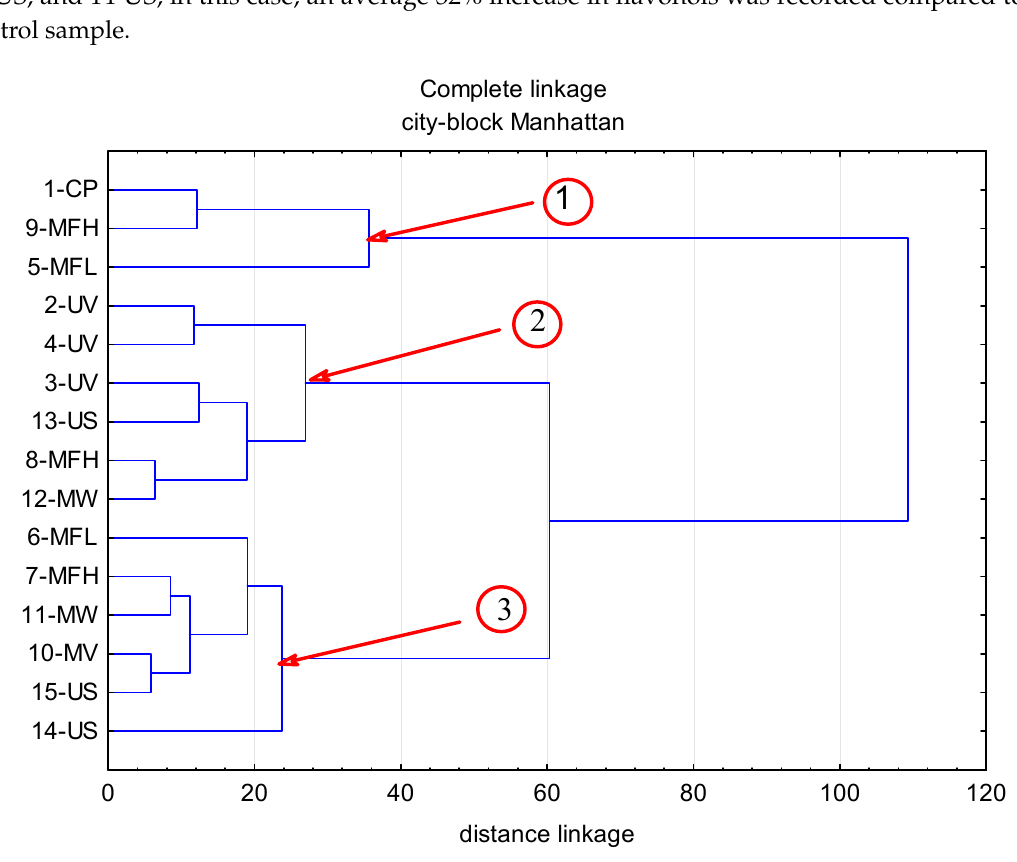
Figure 3. The influence of abiotic stress factors (UV-C electromagnetic field of the microwave field, ultrasound) on the content of flavonols in chokeberry fruits.